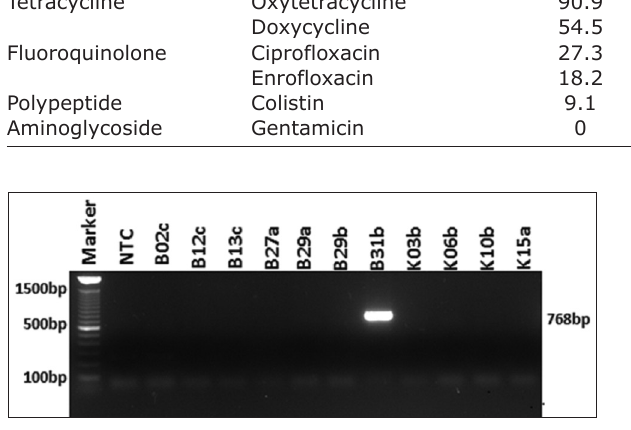
Figure-1: Amplification of bla gene on SHV Klebsiella pneumoniae . A total of one isolate (B31b) showed a positive result of bla . NTC: Non template control. SHV